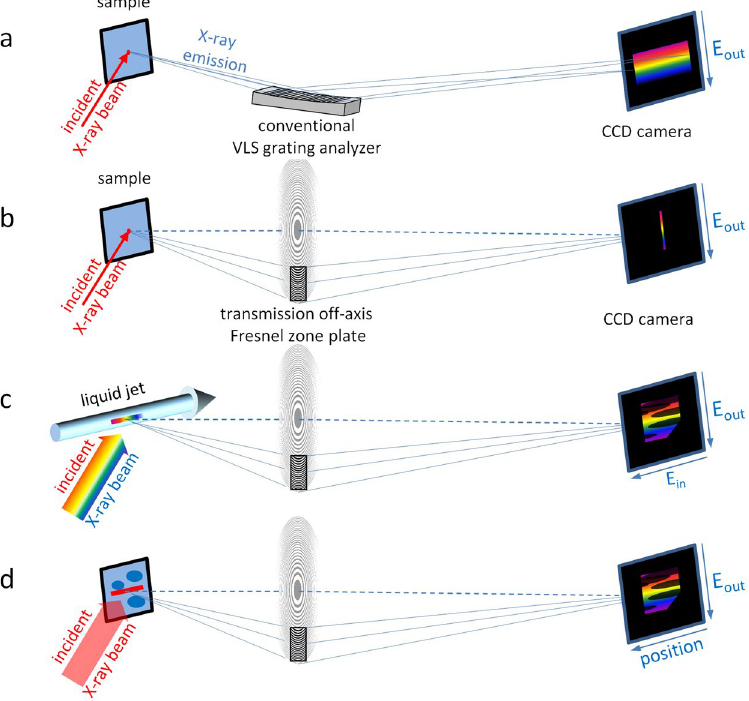
Figure 1. RIXS setup using ( a ) a conventional variable line spacing (VLS) grating analyzer and ( b )–( d ) RIXS setups using an off-axis transmission Fresnel zone plate: ( b ) Focused spot on the sample, leading to a fine dispersed line on detector, the direction perpendicular to the dispersion contains no additional information. ( c ) The photon energy varies along a line focus on the sample (e.g. a liquid jet), which enables to record a full RIXS map simultaneously. ( d ) Monochromatic line focus to scan across the sample, whereas each position leads to a spatially resolved RIXS